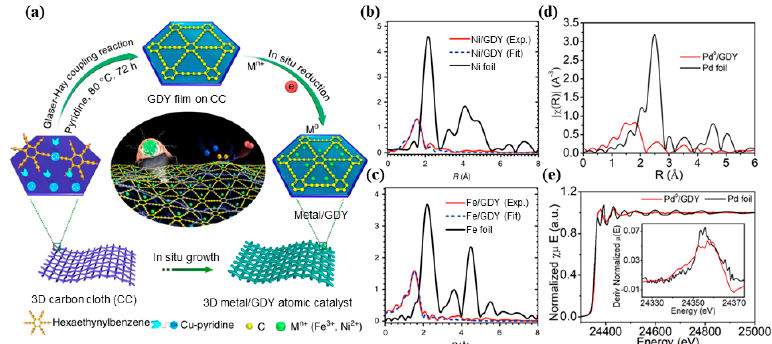
Figure 4. Synthesis and structural characterizations of metal-atom-anchored GDYs. ( a ) Schematic diagram of the synthetic route of Ni/GDY and Fe/GDY; ( b ) EXAFS spectra of Ni/GDY and Ni foil at the Ni K-edge; ( c ) EXAFS spectra of Fe/GDY and Fe foil at the Fe K-edge (reproduced with permission from [67]. Copyright Springer Nature, 2018); ( d ) EXAFS spectra of Pd 0 / GDY and Pd foil at the Pd K-edge; ( e ) normalized Pd K-edge XANES spectra and first-derivative curves (the inset) of Pd 0 / GDY and Pd foil (reproduced with permission from [68]. Copyright Elsevier,